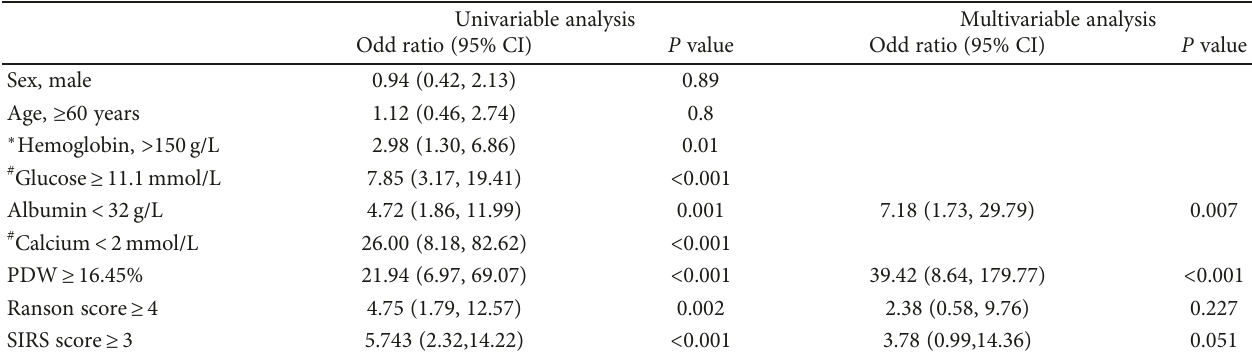
Table 5: Uni- and multivariable logistic regression analyses of risk factors for POF.